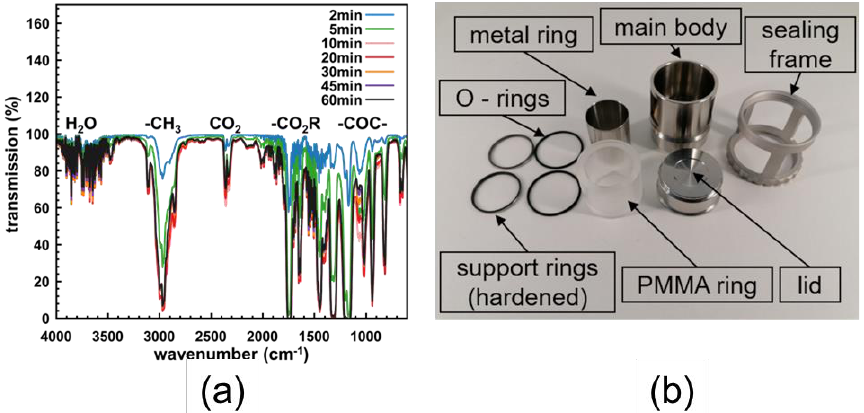
Figure 8. ( a ) IR spectra of the gas phase formed inside the milling vessels obtained in situ during milling with one stainless-steel ball of 15 mm diameter and a PMMA window, ( b ) disassembled milling vessel with the labeled single components including the PMMA window and the inner protecting steel inset. Reprinted with permission of [57]. Copyright 2021, AIP Publishing.